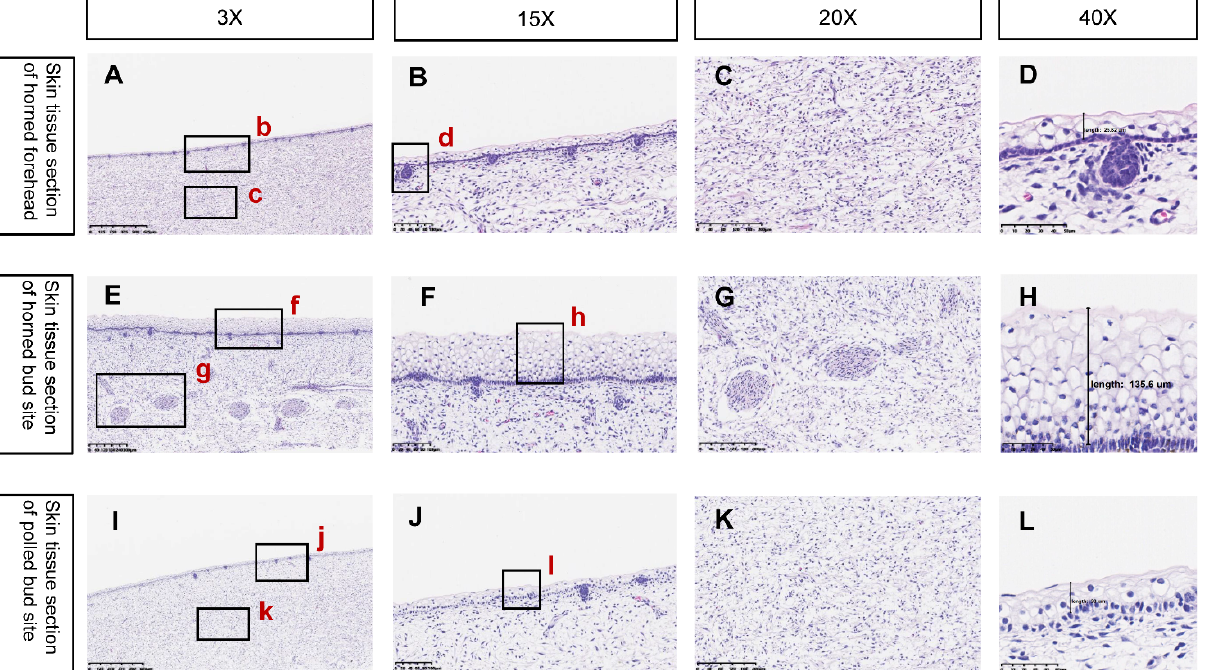
Figure 3. Histological identification of the fetus. ( A – D ) is wild ‐ type frontal skin tissue with normal thickness epidermis, only 2–3 layers of vacuolated keratin ‐ forming cells, epidermis with follicular growth, no thickened nerve bundles found under the skin. ( E – H ) is wild ‐ type skin tissue at the horn bud with more than 10 layers of vacuolated keratin ‐ forming cells and no follicular growth in the epidermis. There are thickened nerve bundles under the skin. ( I – L ) is skin tissue at the horn buds of polled cattle, with a normal thickness of epidermis visible, only 2–3 layers of vacuolated keratin ‐ forming cells, and no thickened nerve bundles found under the horn buds. ( A , I ) magnification ×3, ( E ) magnification ×5, ( B , C , F , G , J , K ) magnification ×10, ( D , H , L ) magnification ×30.